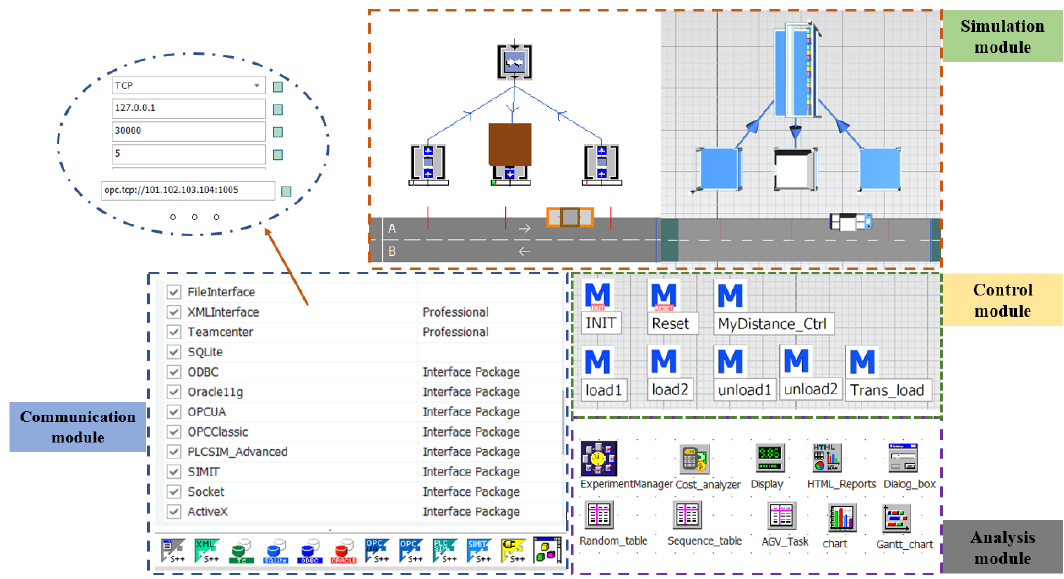
Figure 4. The production simulation and optimization model.